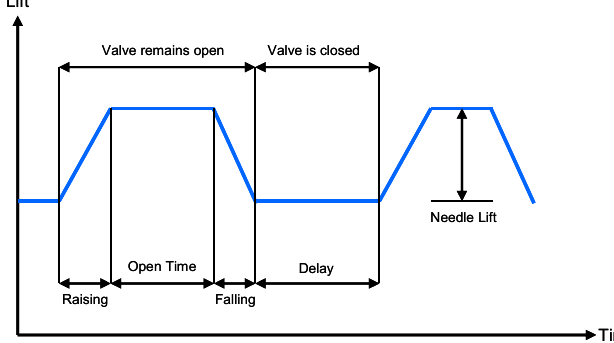
Figure 1. Schematic of dispense sequence and relevant process Figure 1 . Schematic of dispense sequence and relevant process parameters.